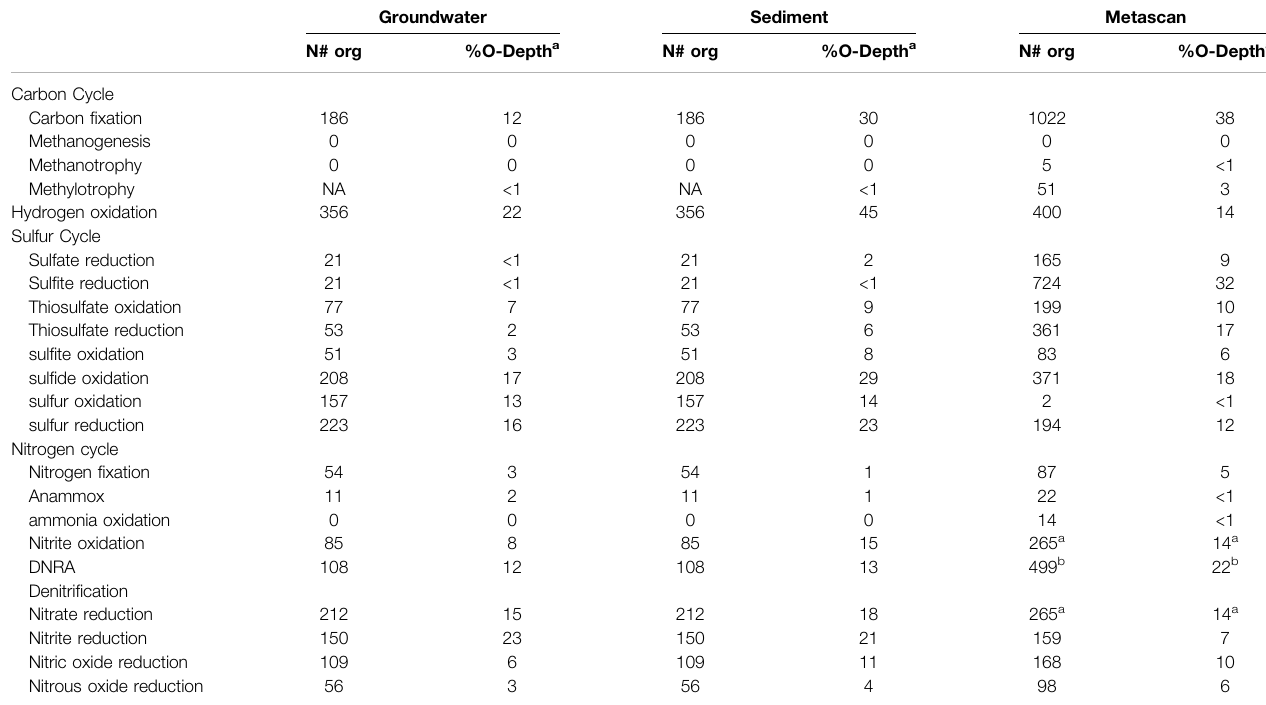
TABLE7| |ResultsfromtheAnantharamanetal.(2016)studyandMetascanbinnedkeygeneanalysis.Groundwaterandsedimentsampleannotationsweretakenarefrom Anantharaman et al.